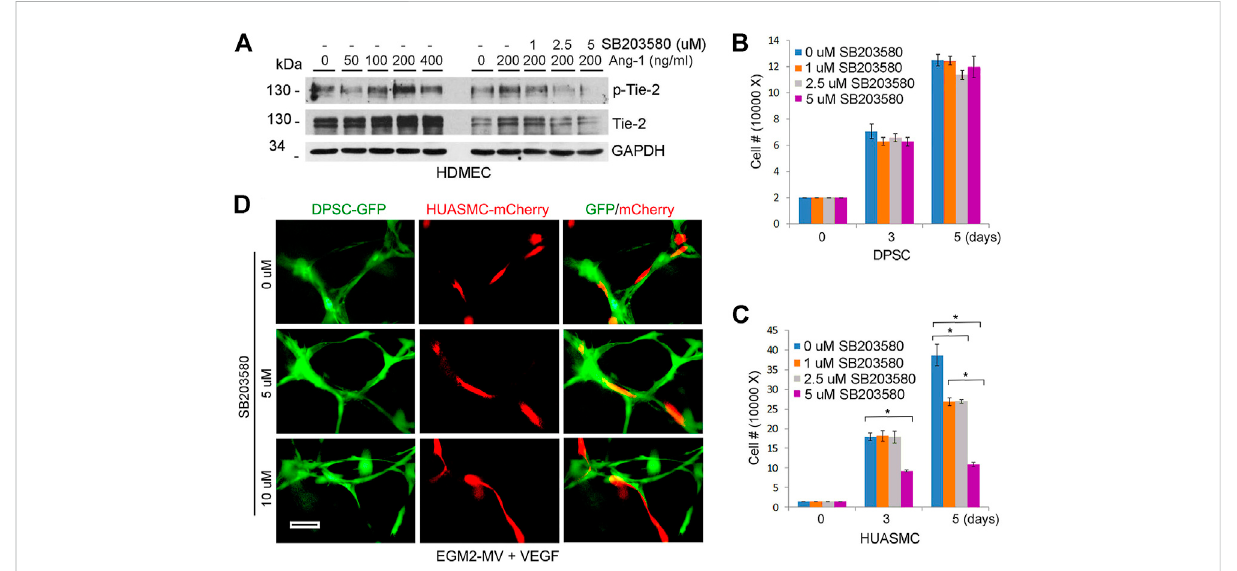
FIGURE 4 Tie-2doesnotcontributetomuralinvestmentofDPSC-derivedcapillaries invitro . (A) HDMECwerestarvedovernightandculturedwith α -MEM supplementedwith5%FBSand0 – 400 ng/mlAng-1inpresenceof0 – 5 µMSB203580(Tie-2inhibitor)for30 min.Westernblotswereperformedfor p-Tie-2, Tie-2. (B,C) 10000 – 40000 DPSC (B) or HUASMC (C) were cultured with α -MEM supplemented with 5%FBS (B) or SMC growth medium (C) in the presence of 0 – 5 µM SB203580. After 5 days, the number of cells were counted under microscopic evaluation. Graphs depicting the number of DPSC (B) and HUASMC (C) in response to the Tie-2 inhibitor. (D) 10000 DPSC or HUASMC were seeded in 12 well plates coated